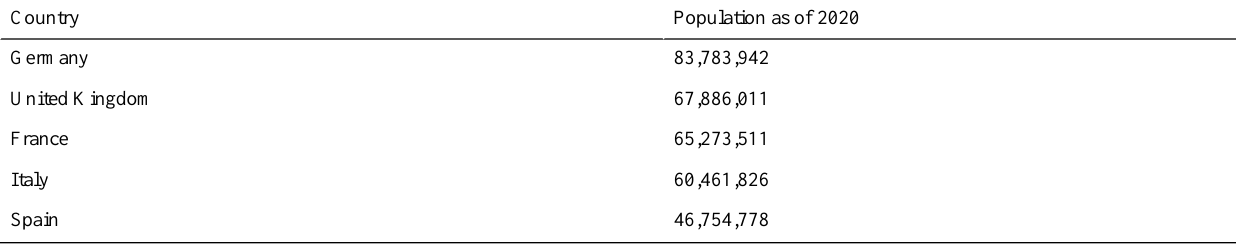
Table 7. Most populous European